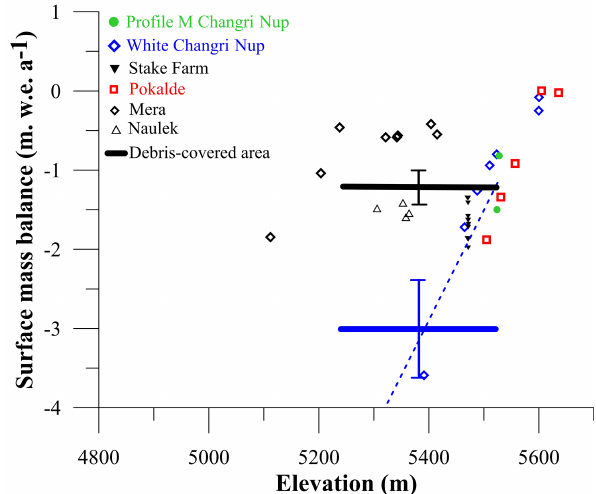
Figure 7. Surface mass balance as a function of elevation for Changri Nup, Mera and Pokalde glaciers over the period 2011– 2015. The upper cross corresponds to the mean surface mass bal- ance obtained on the debris-covered tongue. The blue dashed line represents the mean vertical gradient of mass balance observed at White Changri Nup glaciers and is extrapolated from the mean of SMB measurements at profile M. The lower large cross corresponds to the surface mass balance of a hypothetical clean-ice glacier. Note that surface mass balances of the stake farm on Changri Nup Glacier were measured in 2014–2015 only. The heights of each cross corre- spond to the uncertainty on inferred